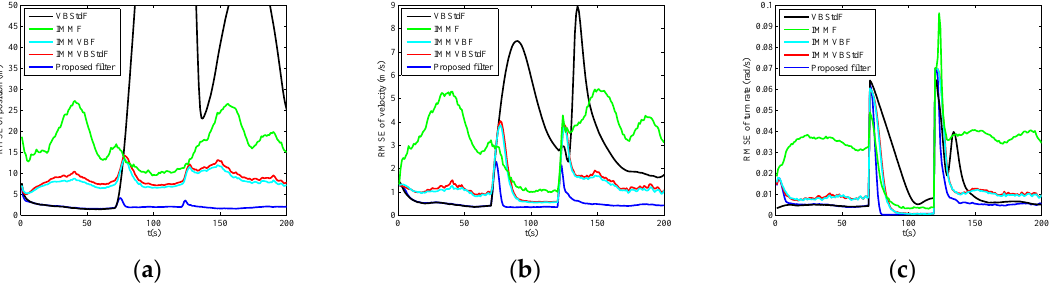
Figure 4. RMSEs versus time in Case C. ( a ) Position; ( b ) Velocity; ( c ) Turn rate.